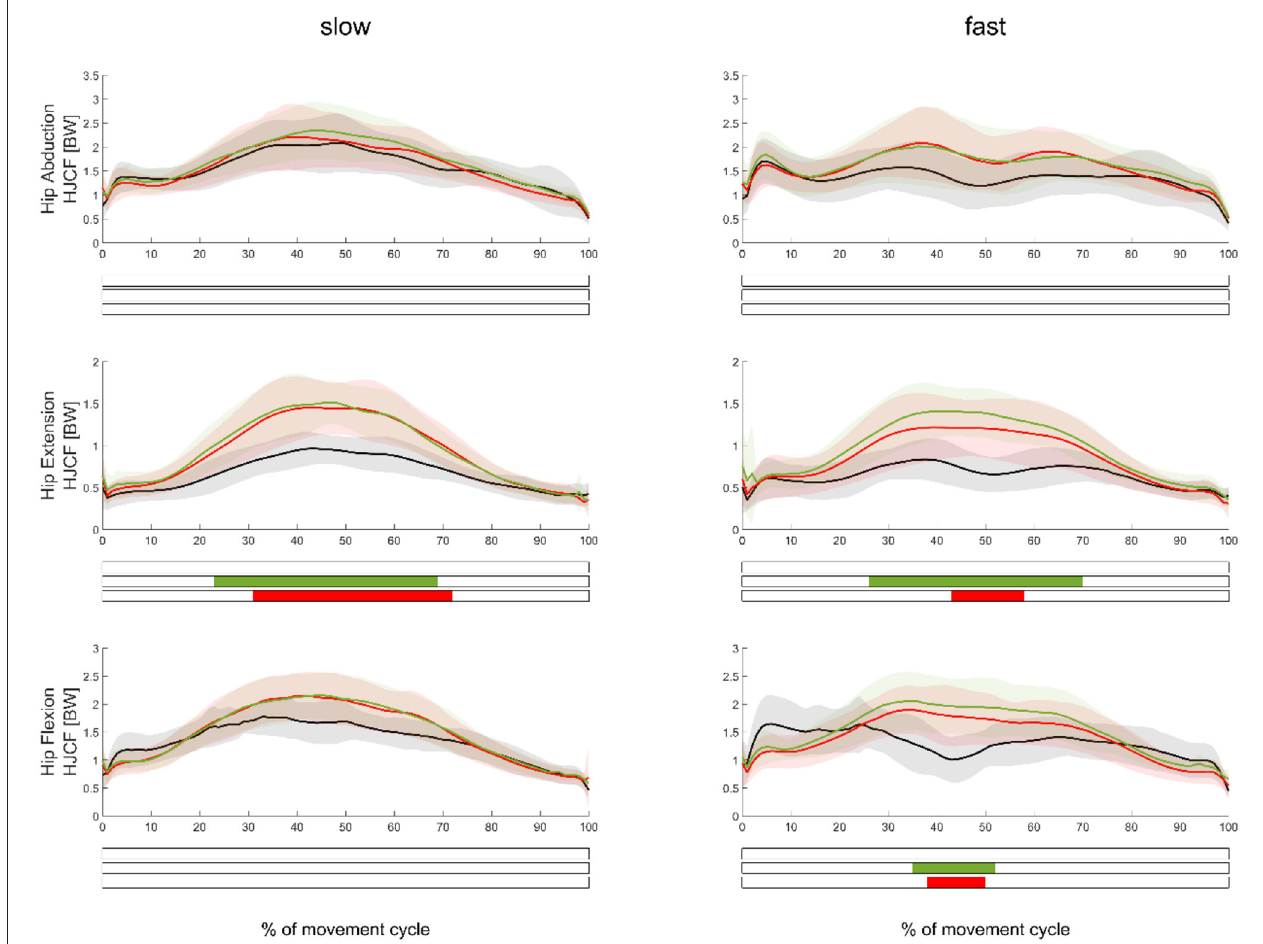
FIGURE 4 | Mean ( ± SD) HJCF waveforms measured in the movement leg during hip abduction (top), extension (middle), and flexion (bottom) exercises, as well as during slow (left subplots) and fast (right subplots) velocities. Green, red, and black waveforms represent the stiffer, softer, and no ERB, respectively. Colored bars beneath each plot indicate significant differences between waveforms, whereas the green, red, and blue (first) bars represent significant differences between the stiffer vs. no ERB, softer vs. no ERB, and stiffer vs. softer ERB,